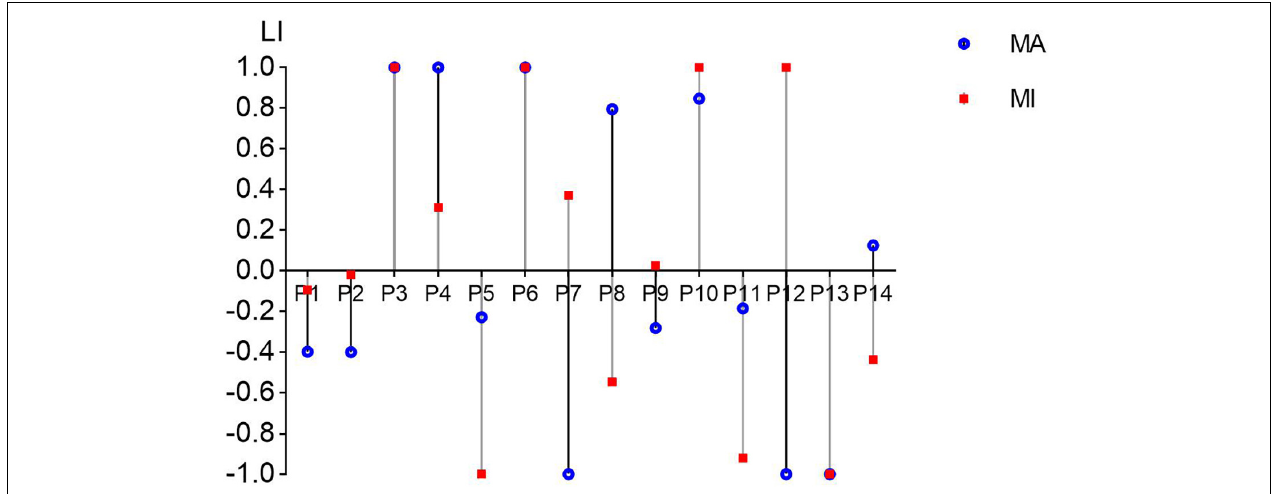
FIGURE 5 | The laterality index (LI) values from C3/C4 channels in all 14 patients in the MA and MI tasks in the 8–30 Hz band. The value range of LI can be from –1 (entirely ipsilesional) to 1 (entirely contralesional). The blue round dots present the LI values of the MA task and the red square dots present the LI values of the MI task.